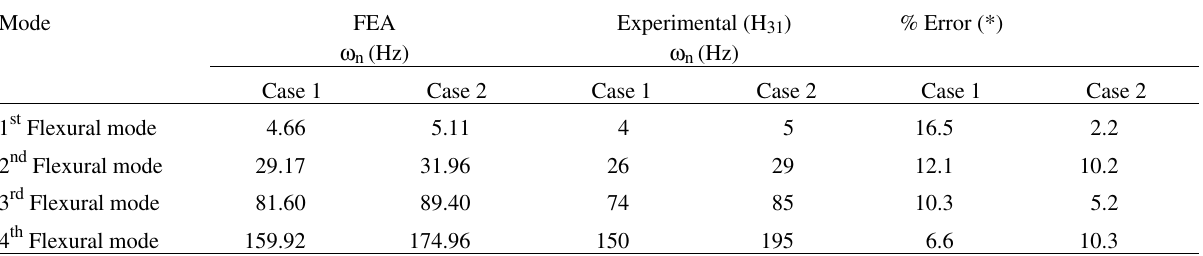
Table 2. Natural Frequencies from FEA and experimental test. Mode